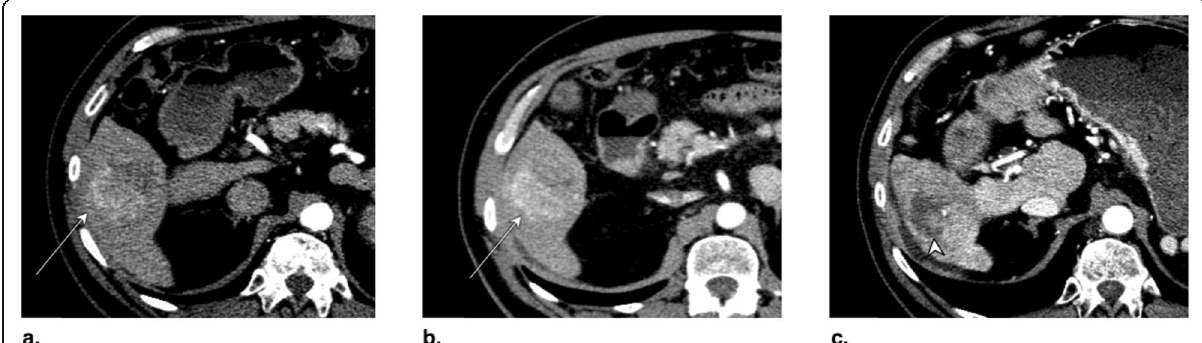
Fig. 33 Axial CT in late arterial phase obtained ( a ) pretreatment: image shows an enhancing 6-cm LR-5 observation in segment VI (arrows). b 1 month post transarterial radioembolization (TARE): image shows no change. c 6 months post TARE: image shows atrophy and diffuse enhancement of segment VI, hypoenhancement at the anterior aspect of the lesion and faint posterior enhancement (arrowhead). These changes may represent treatment-specific expected enhancement pattern or residual tumor. The treated observation is categorized LR-TR Equivocal